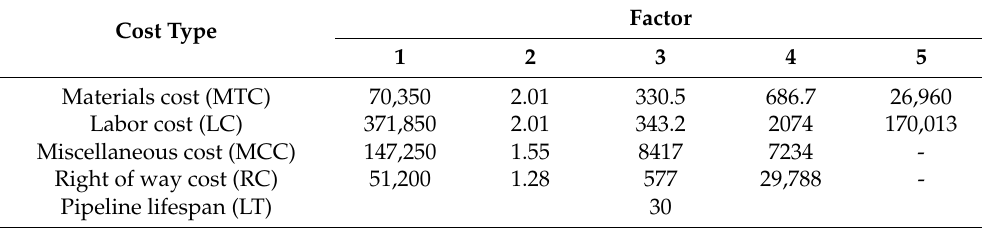
Table 3. Pipeline costs and